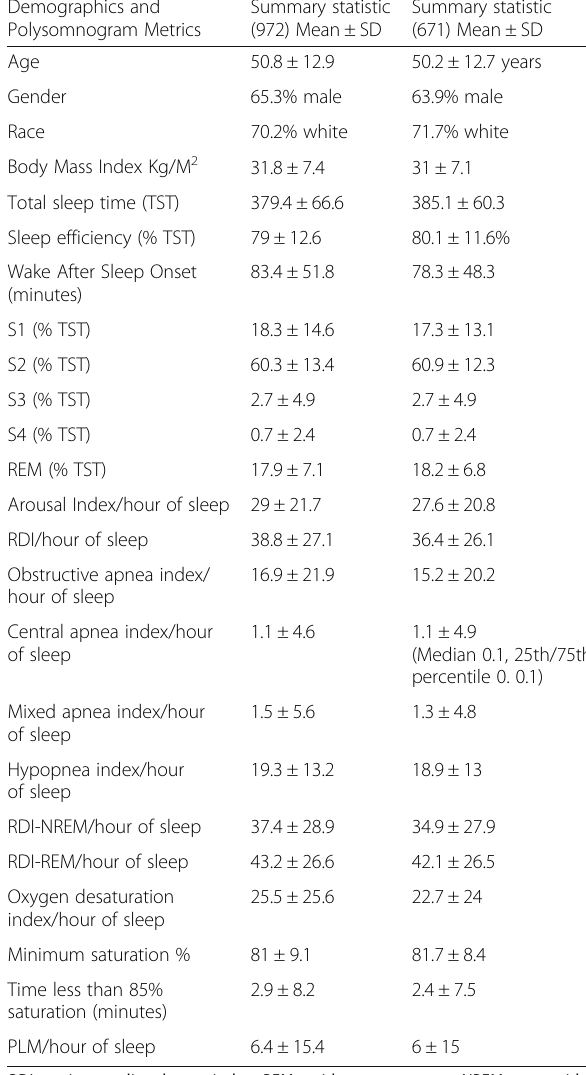
Table 2 Polysomnographic and Demographic features Demographics and Summary statistic Polysomnogram Metrics (972) Mean ± SD